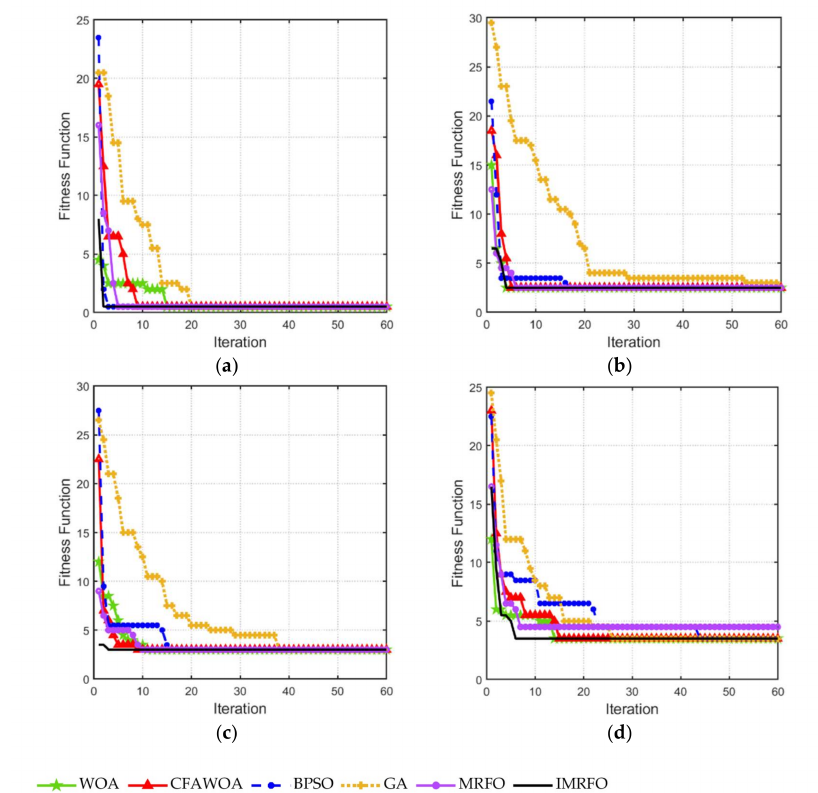
Figure 9. Fault location convergence curve. ( a ) Single fault without information distortion. ( b ) Single fault with information distortion. ( c ) Multiple failures without information distortion. ( d ) Multiple failures with information